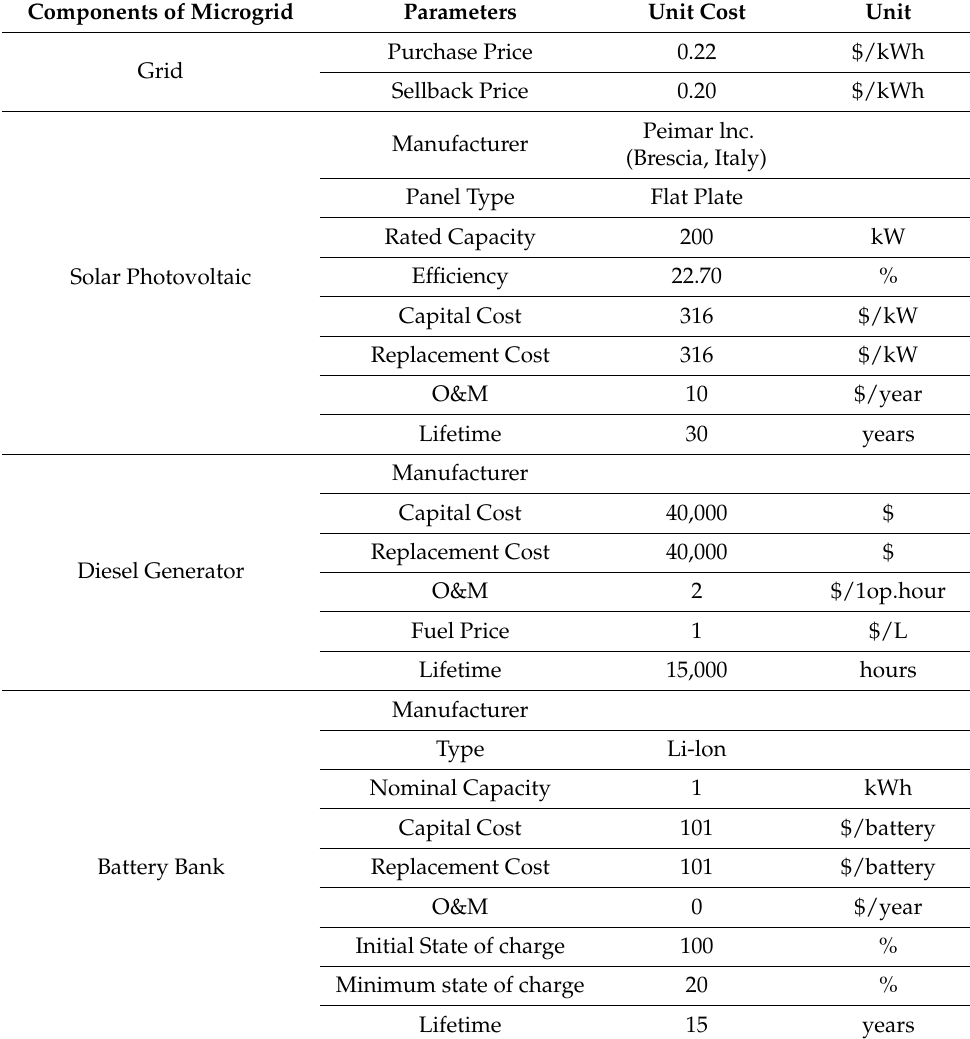
Table 2. Description of microgrid